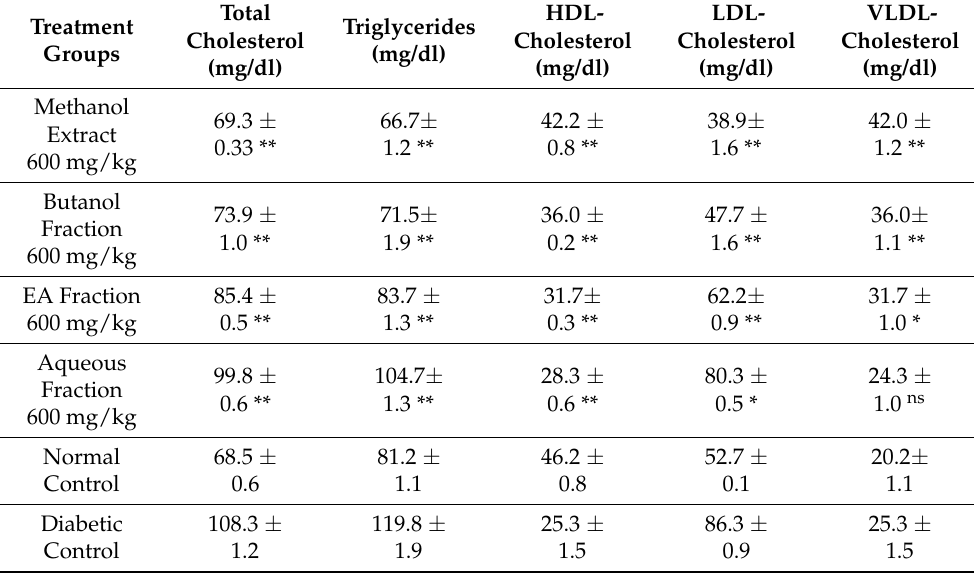
Table 8. Effect of B calliobotrys on lipid profile in diabetic rats on 30th day